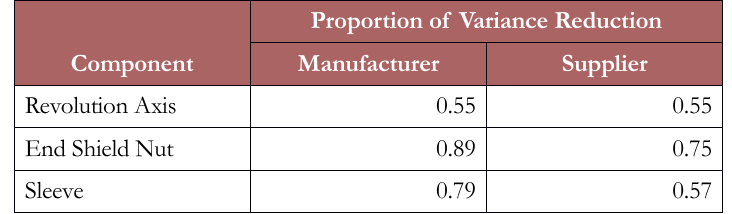
Table 11. Proportion of Variance Reduction in fourth cycle